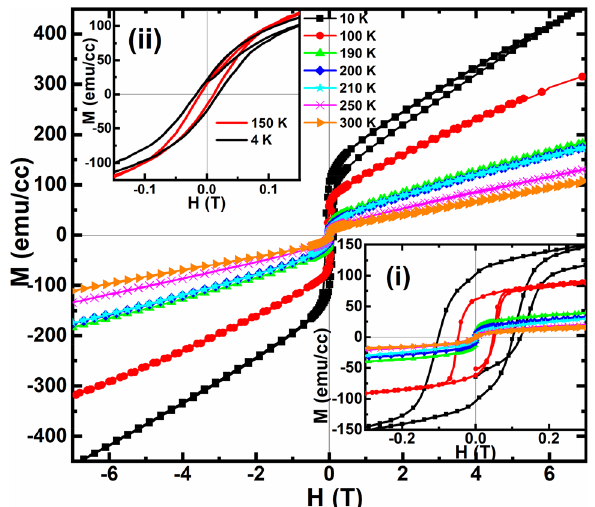
Figure 5. Magnetic field-dependent magnetization measurement at various temperatures for PSMO/PCMO/ STO heterostructure. Insets (i) and (ii) show the enlarged view of the hysteresis loop obtained for the PSMO/ PCMO/STO heterostructure and the PCMO(15 nm)/STO thin